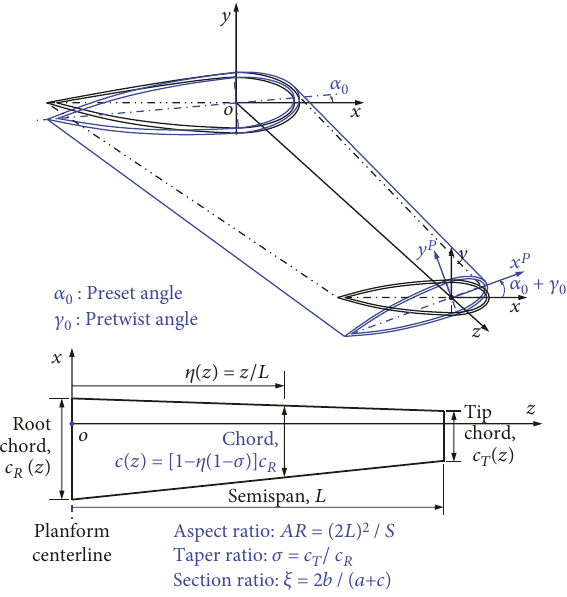
Figure 2: The mathematical